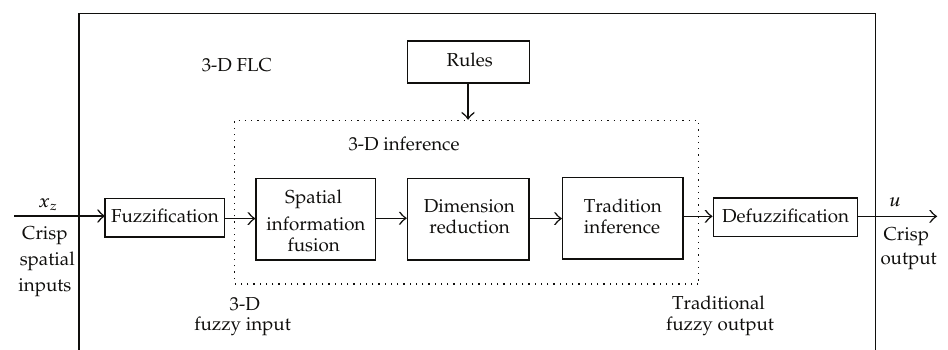
Figure 2: Basic structure of a 3-D